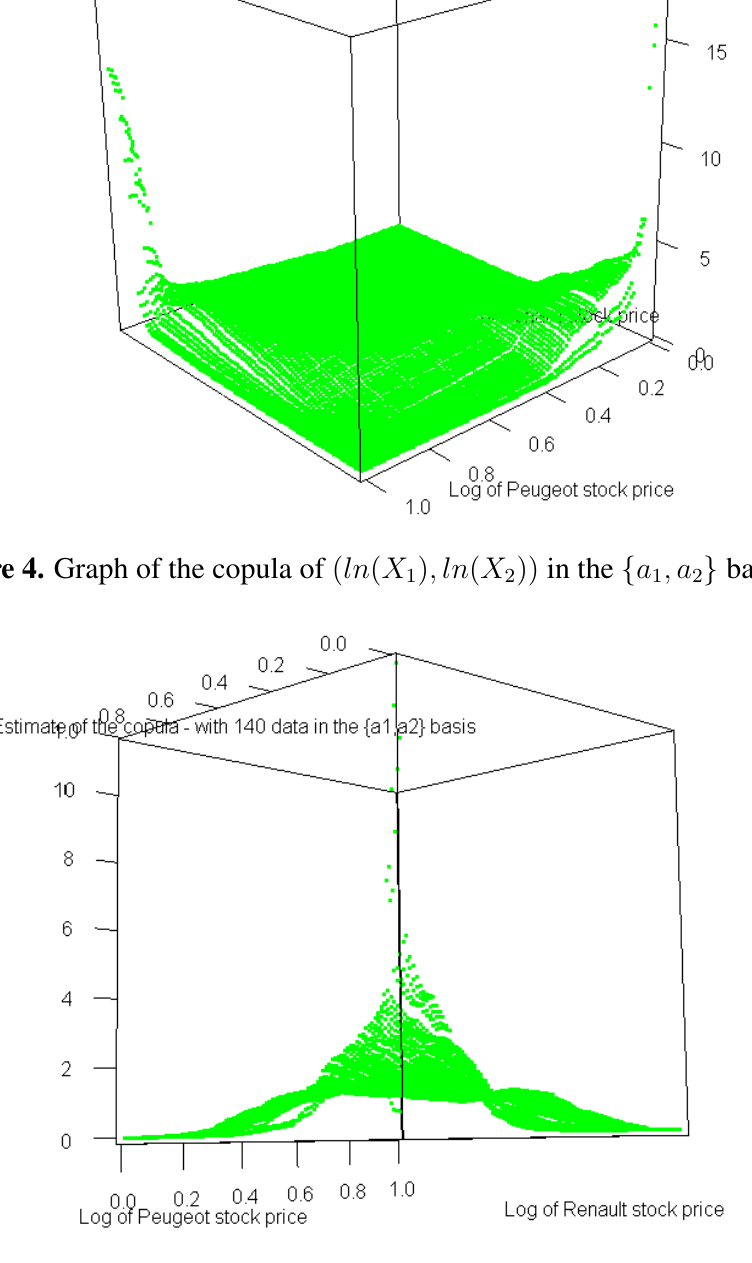
) , ln ( X )) in the canonical basis. 1 2